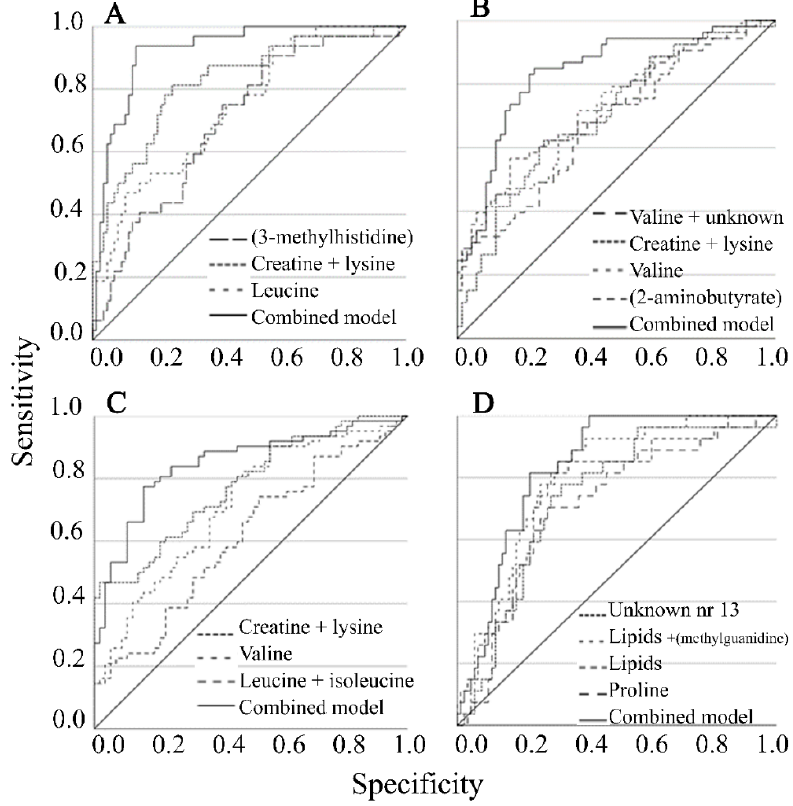
Figure 1. Area under the curve for single metabolites and combined metabolite models for ( A ) red meat, ( B ) eggs, ( C ) fermented dairy, ( D ) beer. Diagonal line represents the reference line.